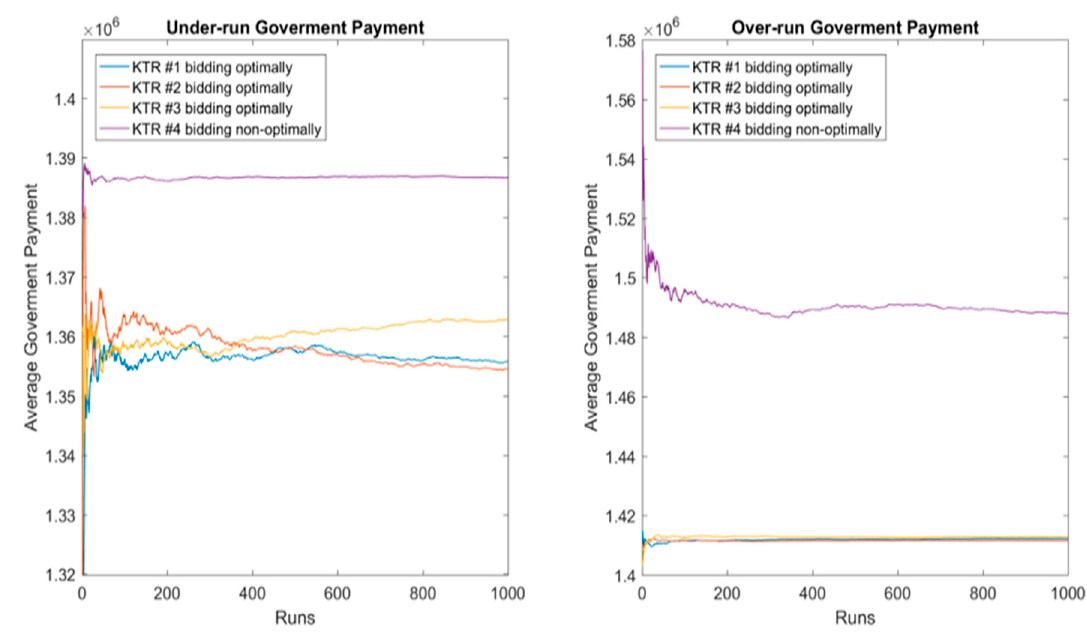
Mathematics 2018 , 6 , x Figure 13. CPIF DAA-AWGE Average Government Payments. Figure 13. CPIF DAA-AWGE Average Government Payments.